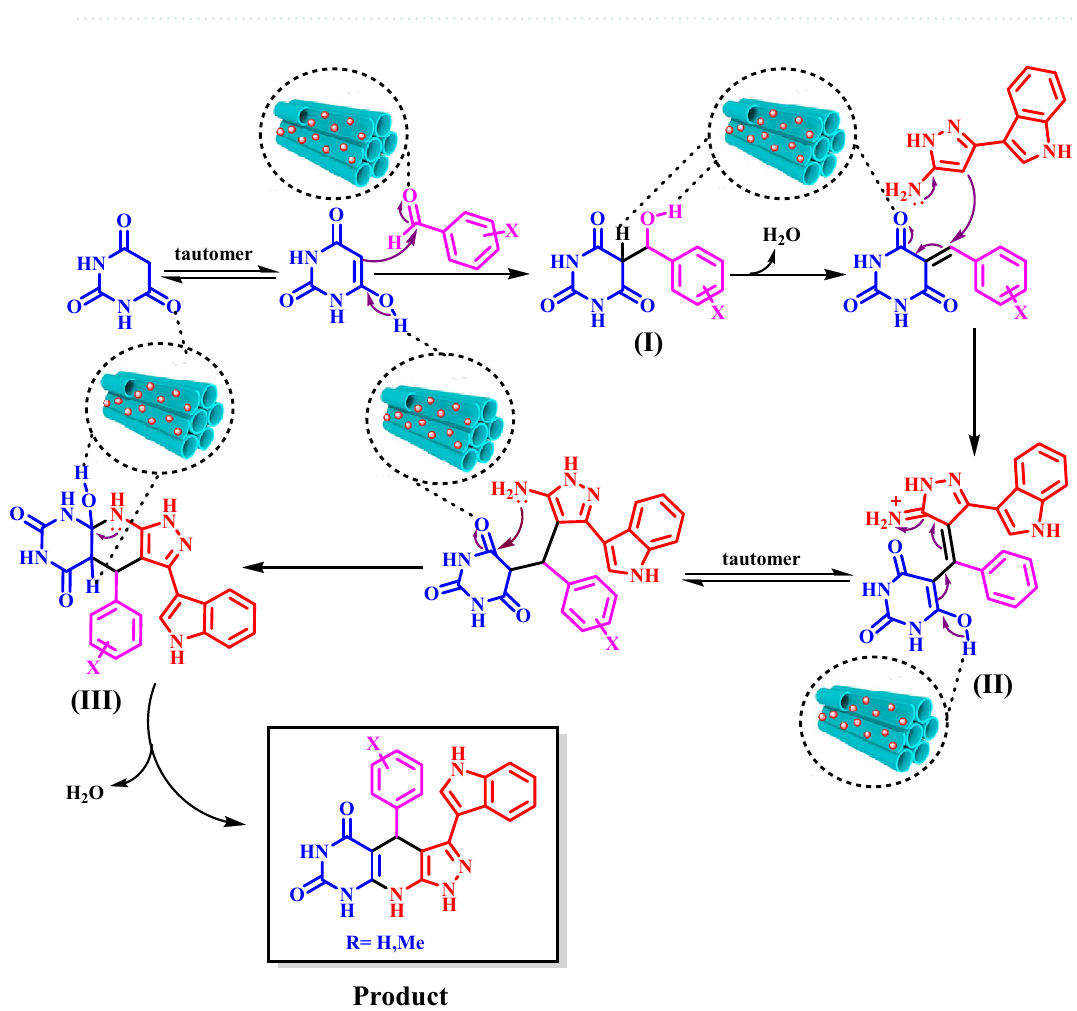
Figure 10. Proposed mechanism for the synthesis of pyrazolo[4 ′ ,3 ′ :5,6]pyrido[2,3- d